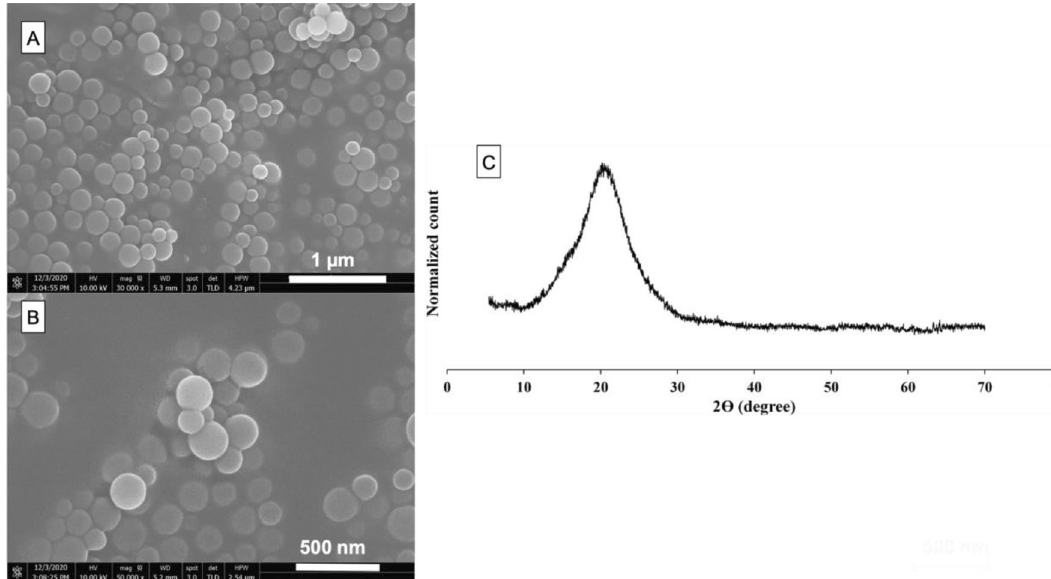
Figure 1. ( A , B ) SEM images and ( C ) XRD pattern of the Sr-bioactive glass nanoparticles